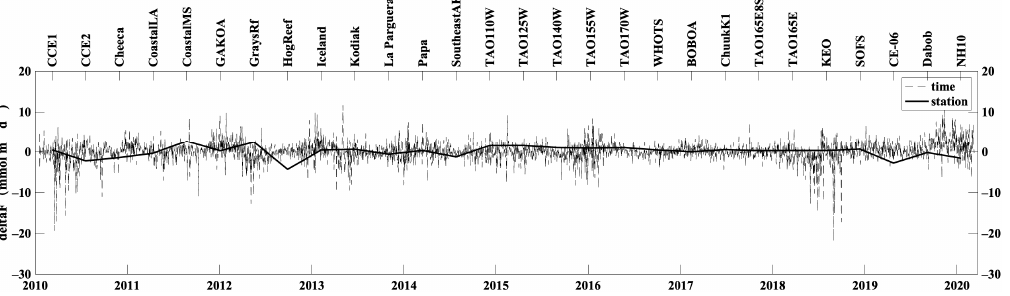
Figure 5. Average difference in the CO 2 flux calculated with and without the nocturnal effect at global buoy stations, with deltaF = F real − F day , the upper abscissa as the names of the global stations, and the lower abscissa as time. -- shows the value corresponding to the time of the horizontal coordinate; — shows the value corresponding to the station of the horizontal coordinate.